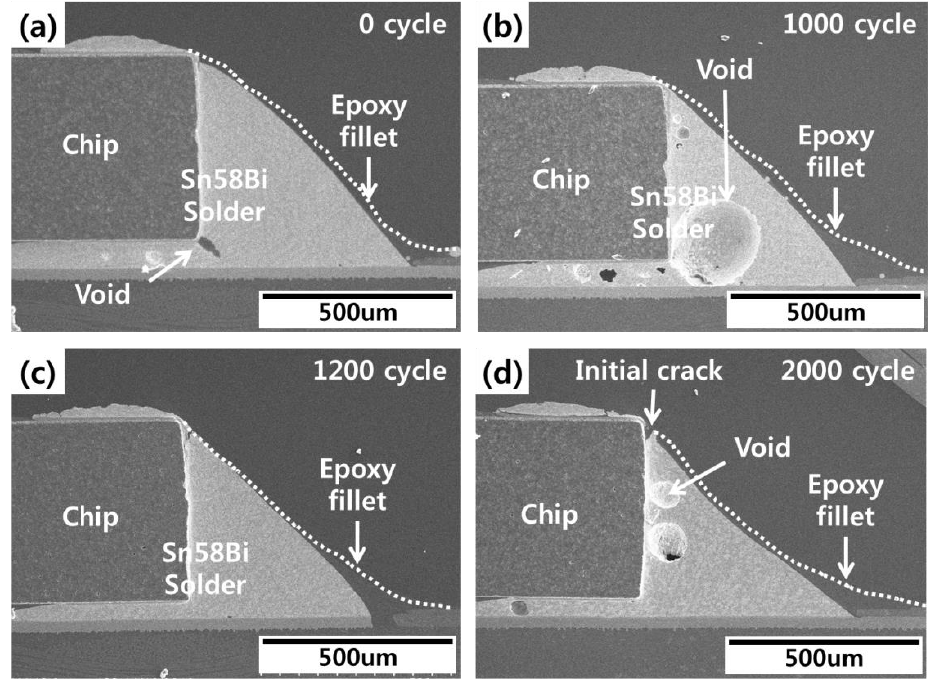
Figure 12. Epoxy Sn58Bi solder joint images during thermal shock testing: ( a ) 0 cycles, ( b ) 1000 cycles, ( c ) 1200 cycles, and ( d ) 2000 cycles.